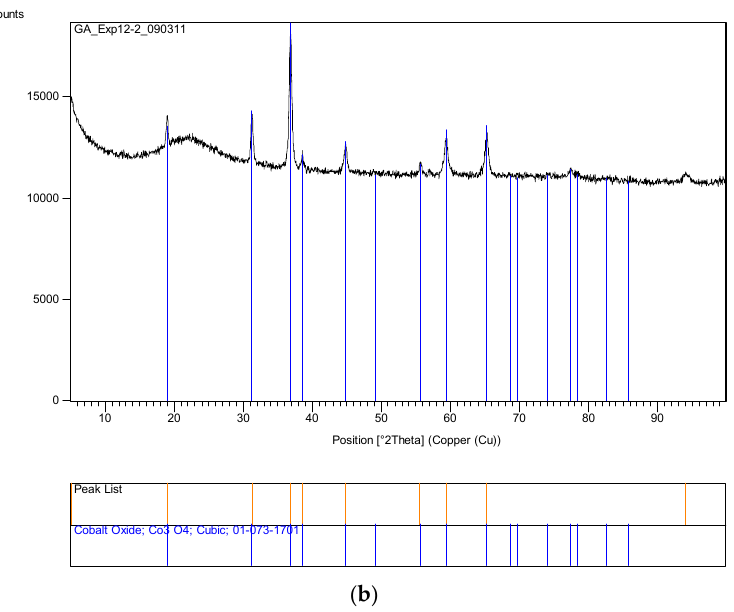
Figure 14. XRD pattern of the uncoated silica with cobalt nitrate (Co/Si = 1/4 Haake Mixer ‐ Y) before and after heat treatment at 600 °C. ( a ) Sample obtained from mixing in a Haake Mixer; ( b ) After heat treatment at 600 °C using Method ‐ C, Section 3.8 (Co/Si = ¼ Haake Mixer ‐ YB).